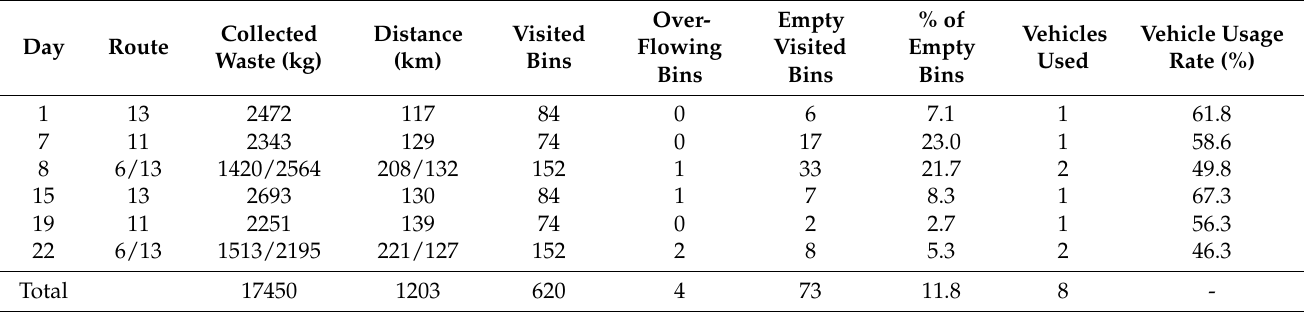
Table 9. Proposed operations